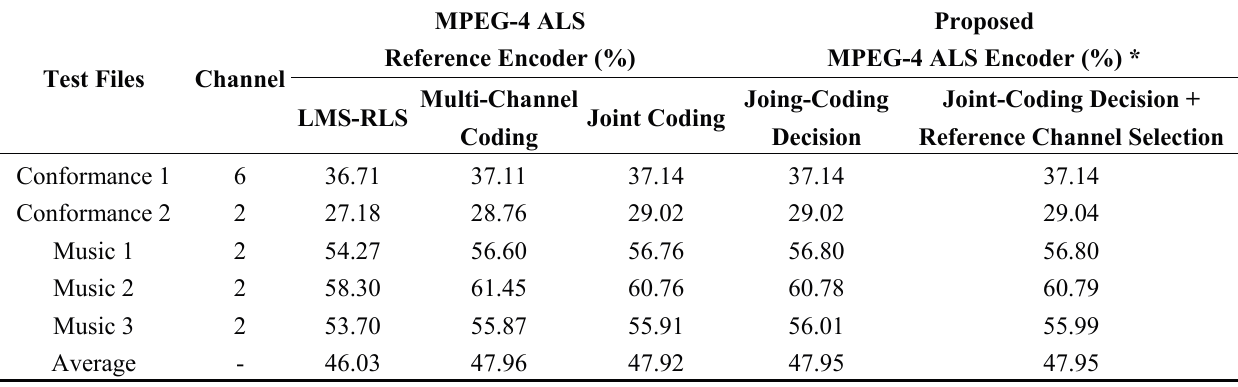
Table 1. Compression ratio of the proposed MPEG-4 ALS encoder.